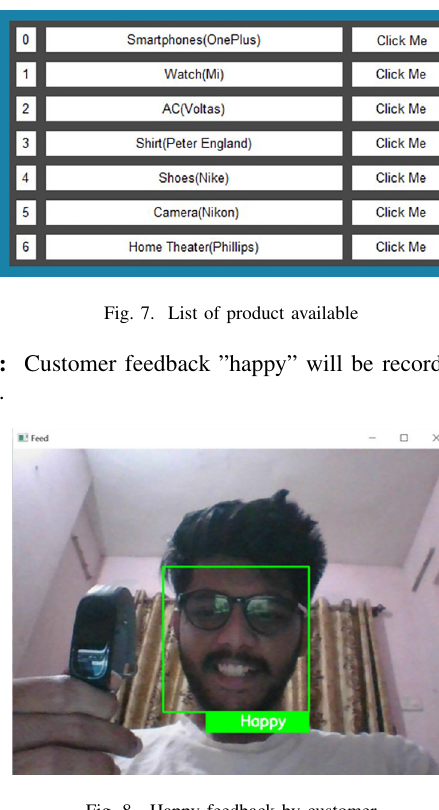
Fig. 10. Product feedback visible to